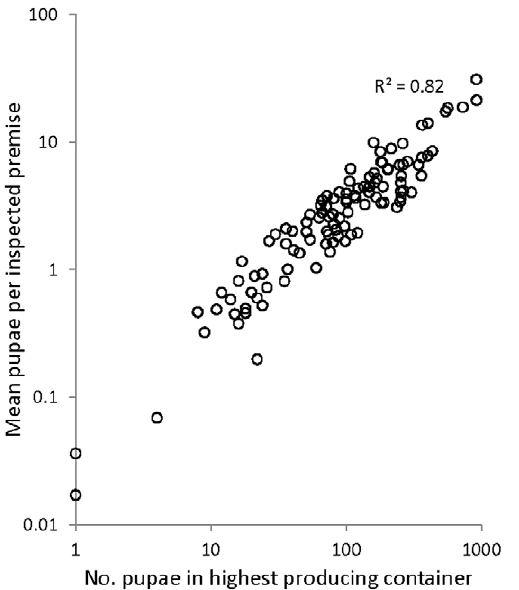
Figure 2. Relationship between pupal abundance in highest producing container and average pupae per premise across 112 patch-surveys in Armenia. doi:10.1371/journal.pntd.0001799.g002 PLOS Neglected Tropical Diseases |